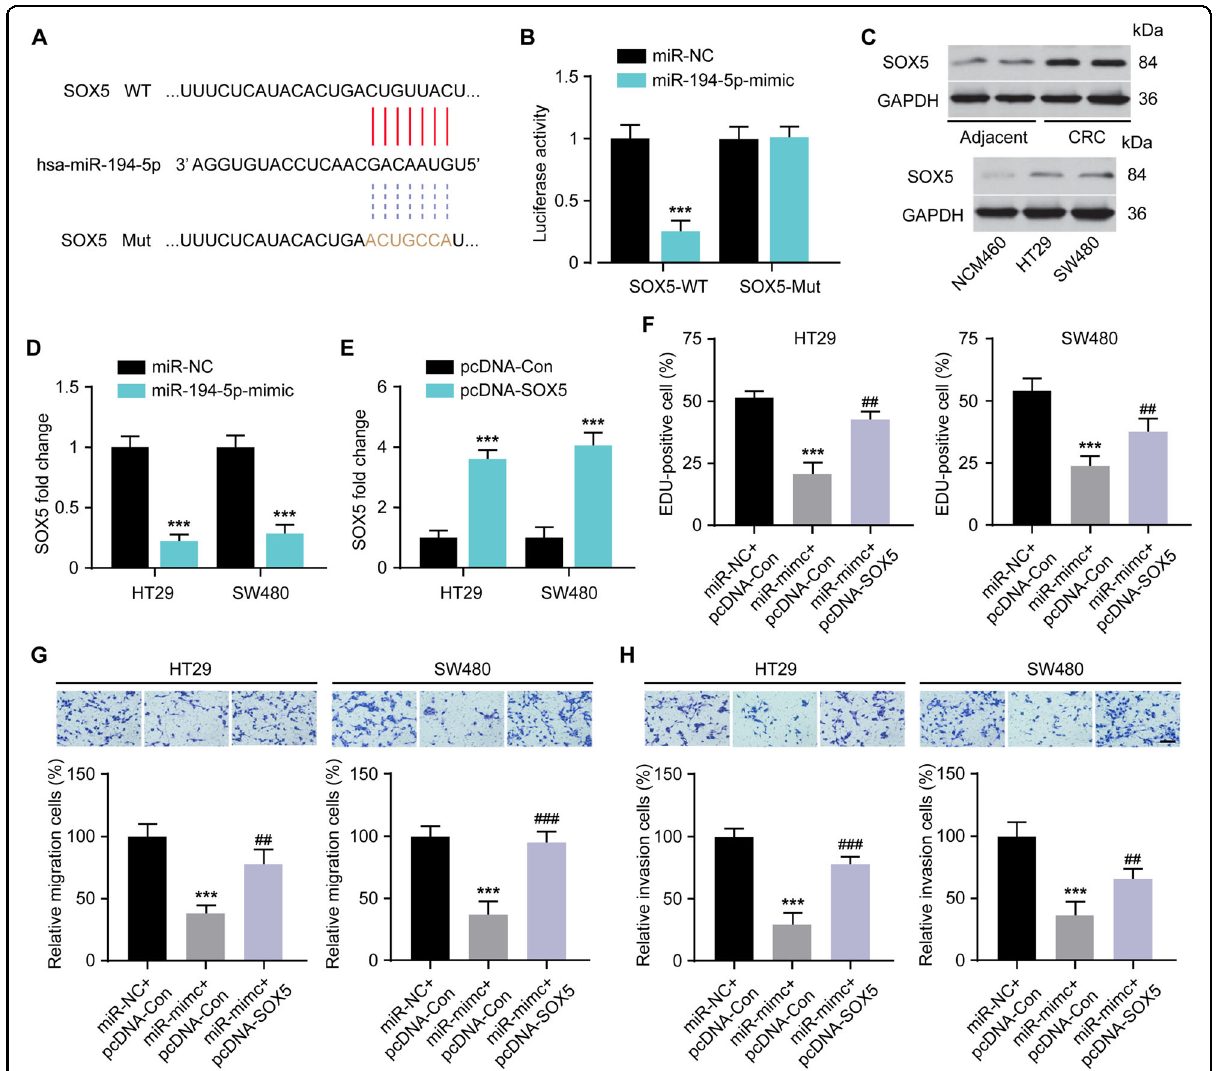
Fig. 6 SOX5 is a direct target of miR-194-5p and its upregulation reverses the impacts of miR-194-5p on CRC cells. A The putative binding site between SOX5 and miR-194-5p through prediction of TargetScan online software. B luciferase reporter assay for analysis of the interaction between SOX5 and miR-194-5p, *** P < 0.001 vs. miR-NC. C western blotting was performed to detect the protein expression levels of SOX5 in CRC tissues and CRC cell lines. D qRT-PCR was performed to determine the effect of miR-194-5p-mimic in decreasing SOX5 expression in HT29 and SW480 cells, *** P < 0.001 vs. miR-NC. E HT29 and SW480 cells were transfected with pcDNA3.1-SOX5 and the fold changes in the expression of SOX5 was analyzed, *** P < 0.001 vs. pcDNA-Con; EDU ( F ), migration ( G ), and invasion ( H ) assays were conducted respectively in HT29 and SW480 cells mentioned above, *** P < 0.001 vs. miR-NC + pcDNA-Con; ## P < 0.01, ### P < 0.001 vs. miR-mimic + pcDNA-Con. Scale bar = 50 μ m. Data were expressed as mean ± SD. All experiments were repeated three